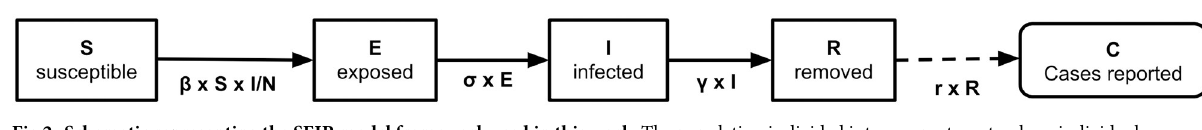
Fig 2. Schematic representing the SEIR model framework used in this work. The population is divided into compartments where individuals transition through the compartments: Susceptible, Exposed, Infected, Removed, Case reported, where the transitions are described by ODEs (Eq (3)).